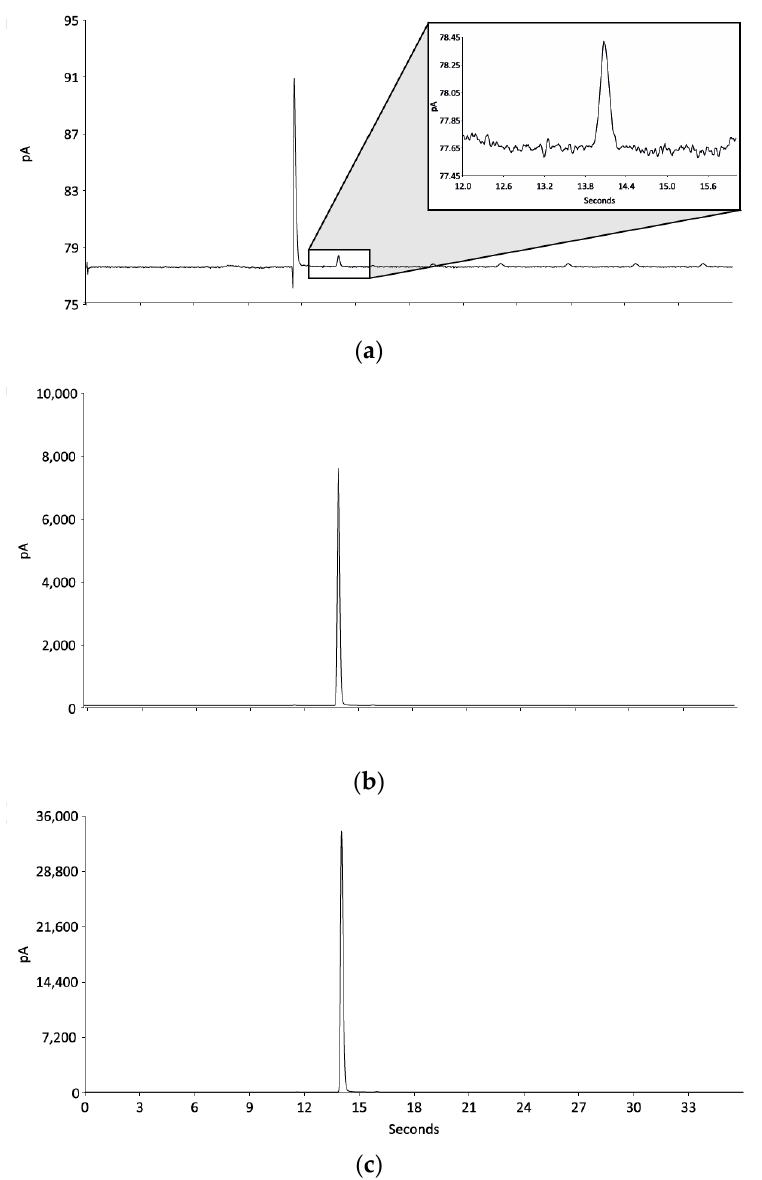
Figure 1. Chromatograms for three different concentrations of ethanedinitrile ( a ) low: 0.6 ppm, ( b ) medium: 5,000 ppm and ( c ) high: 25,000 ppm and their relative intensities.